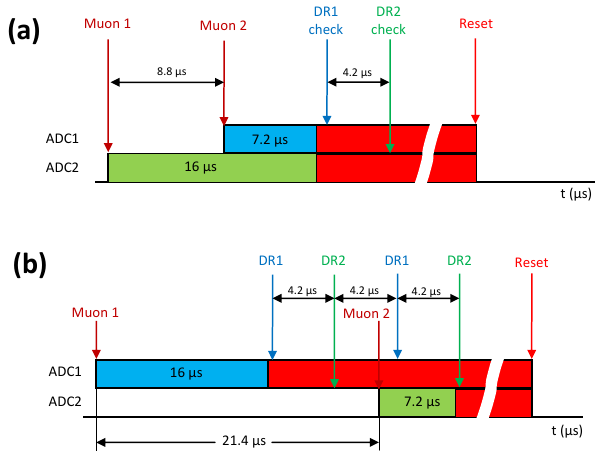
Figure 9. Different muons considered like a single particle (coinci- dent) because of ADC conversion time (blue and green) and soft- ware checking time (4.2µs between DR1 and DR2). In red, the time from the ADC end of conversion to DA activation. DR1 check: